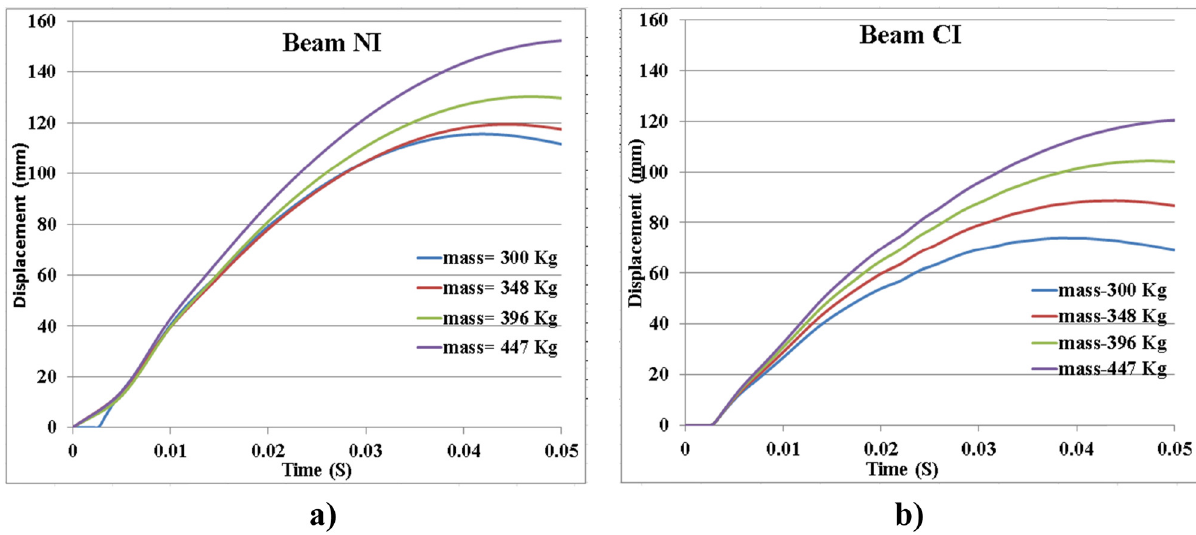
Figure 7: Displacement – time history for di ff erent impact masses. ( a ) For the NI beam and ( b ) for the CI